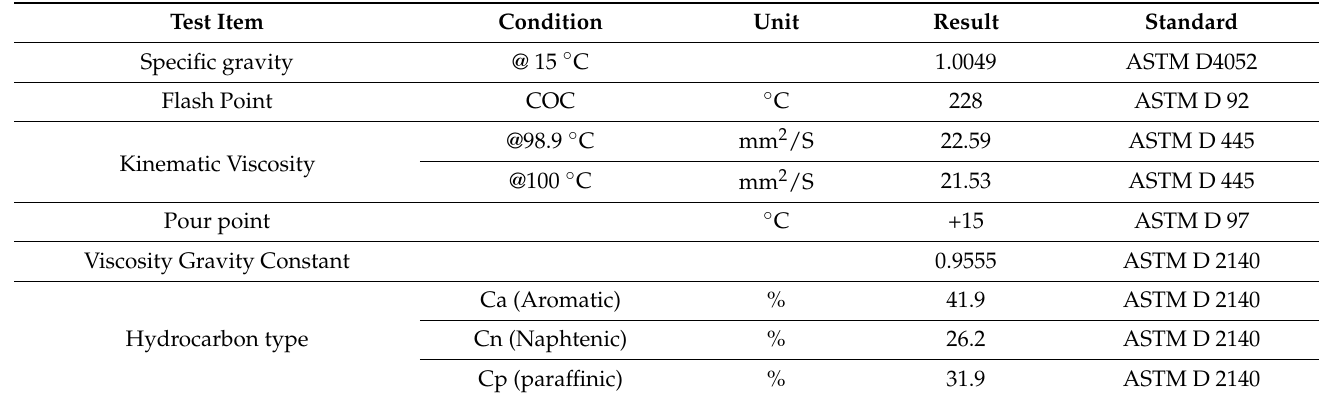
Table 2. Properties of processed